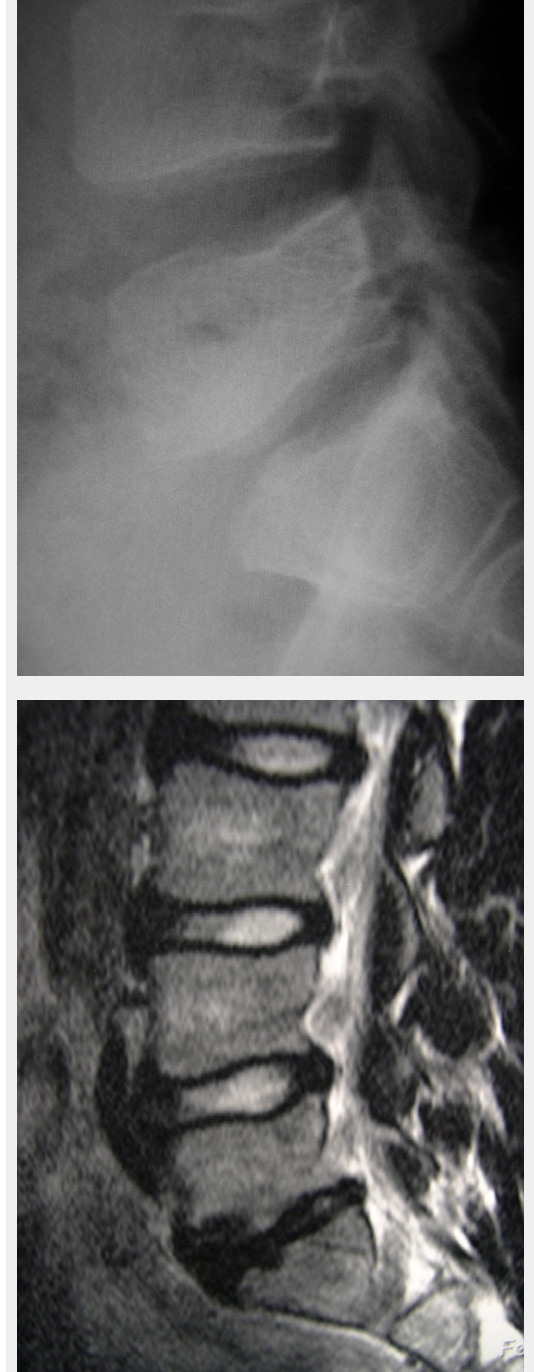
Figure 2 A Lumbosacral stress response in a 14-year-old adolescent high level mountain bike downhill racer with a 12 month history of activity-related lumbar back pain which did not respond to physiotherapy. Refrain from sport, an intense physiotherapy programme and a lumbar brace led to complete pain relief. A standard lateral standing radiograph of the lower lumbar spine: Disk space narrowing at the level L5/S1. Endplate irregularities of the fifth lumbar vertebra and the first sacral vertebra. Normal sagittal spinal contour. The anteroposterior radiograph was found to be normal. B T2 weighted Magnetic Resonance Image. Lateral sagittal plane. Dehydration of disk L5/S1 with subsequent disk space narrowing and posterior bulging of the disk. Anterior osseous destruction of the first sacral vertebra. Marked anterior Schmorl’s nodes at the lower endplate of L5 and upper endplate of